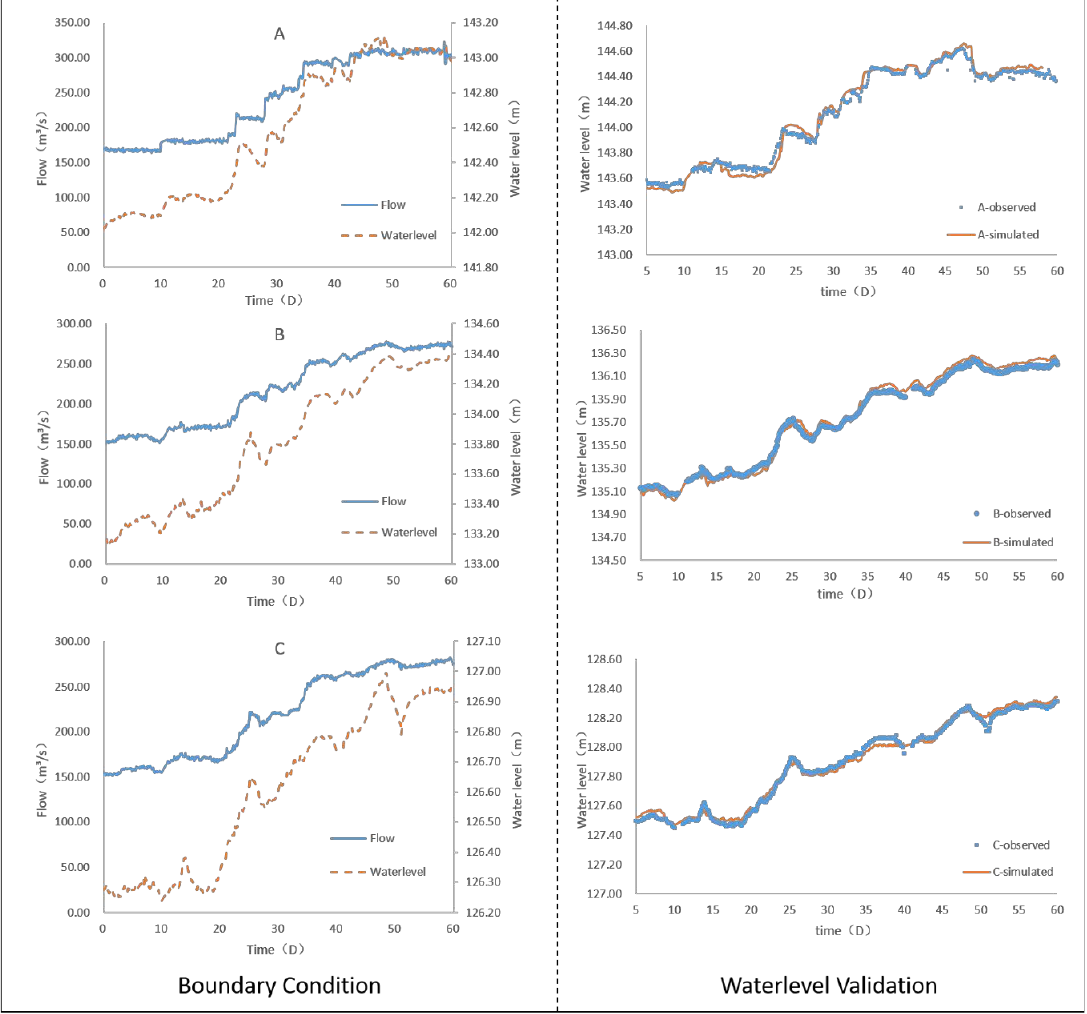
Figure 5. Boundary conditions and model validation.